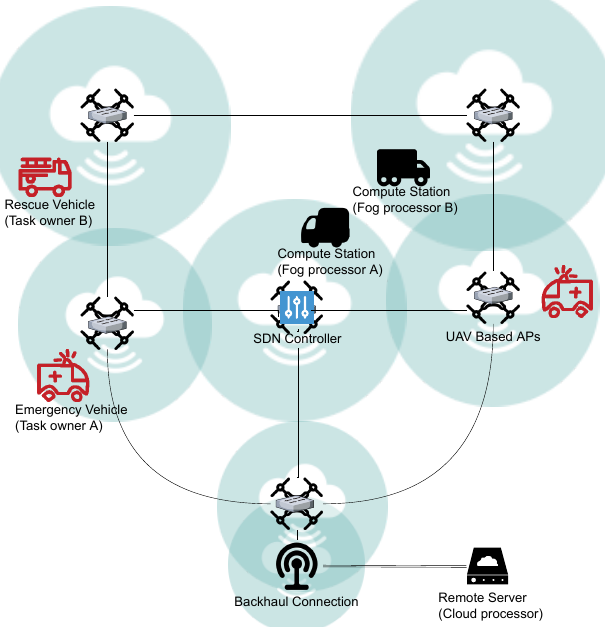
Figure 1. Multi-UAV edge network model investigated in our